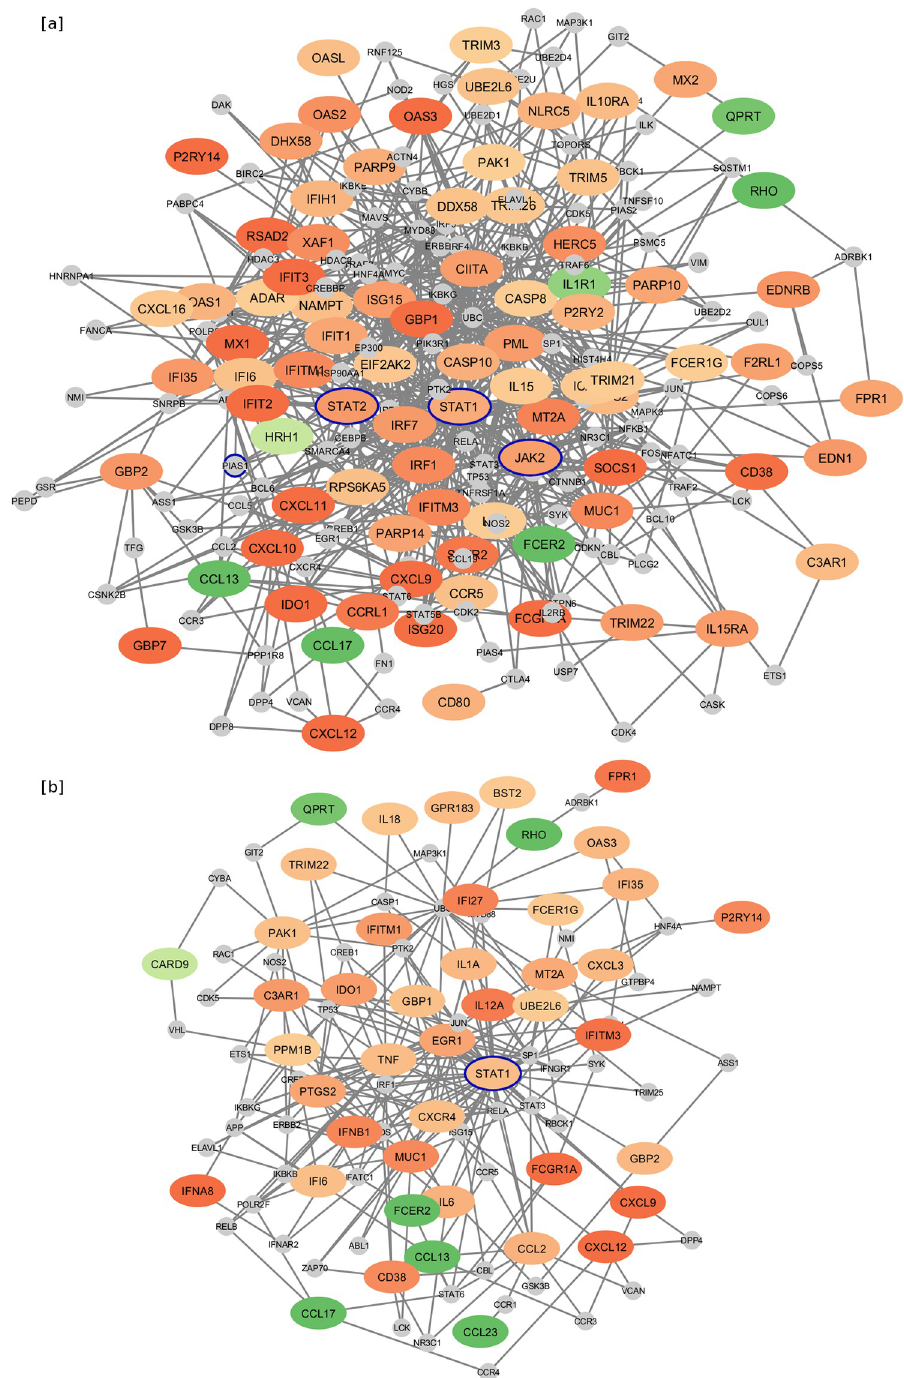
Fig 3. Minimal first order protein:protein interaction networks of genes in primed activation pathways. Comparing (a) uninfected M1 vs. uninfected M2 and (b) infected M1 vs infected M2 macrophages. Red-orange genes are upregulated while green genes are downregulated, with darker shades indicating a greater fold change. Smaller grey circles indicate genes that were not differentially expressed, but connect two or more differentially expressed genes in the network. Genes of interest STAT1, STAT2, JAK2, and PIAS1 are outlined in blue for emphasis.